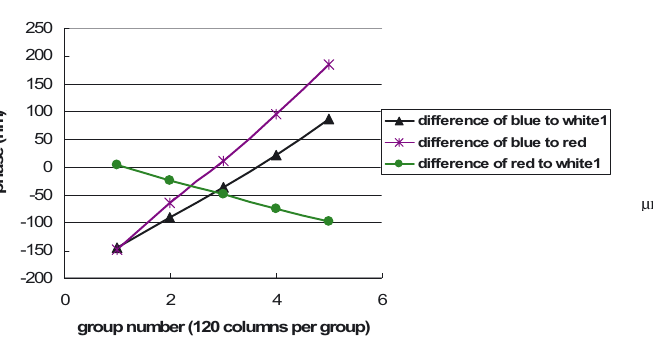
Fig. 5. Difference in distortion between different wavelengths.